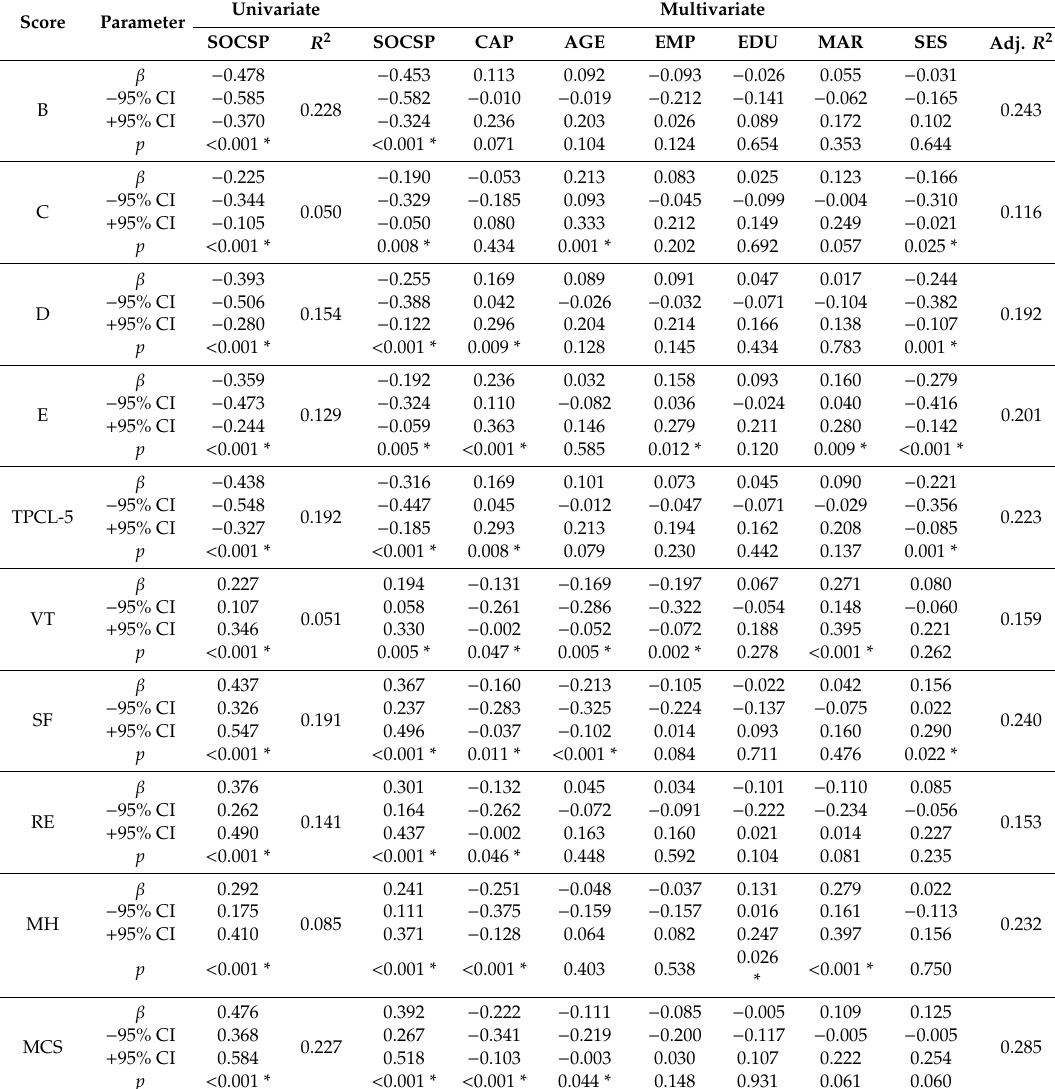
Table 4. Regression analysis and factors associated with the di ff erent perception of social